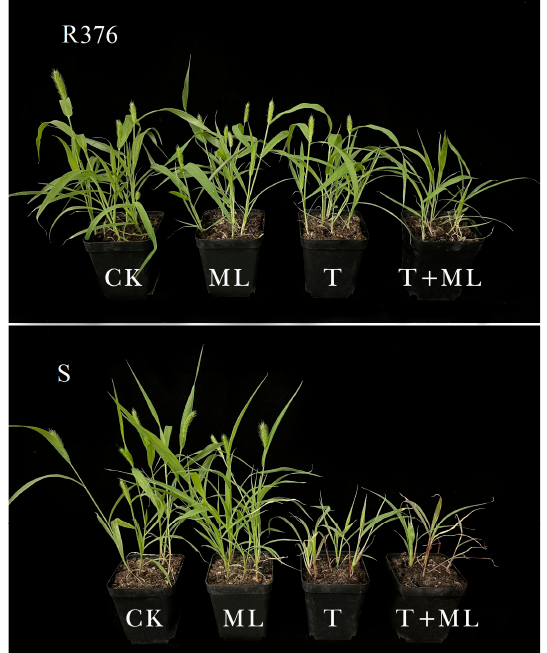
Table 1. Values of GR 50 to nicosulfuron for S and R376 S. viridis populations with and without mal-